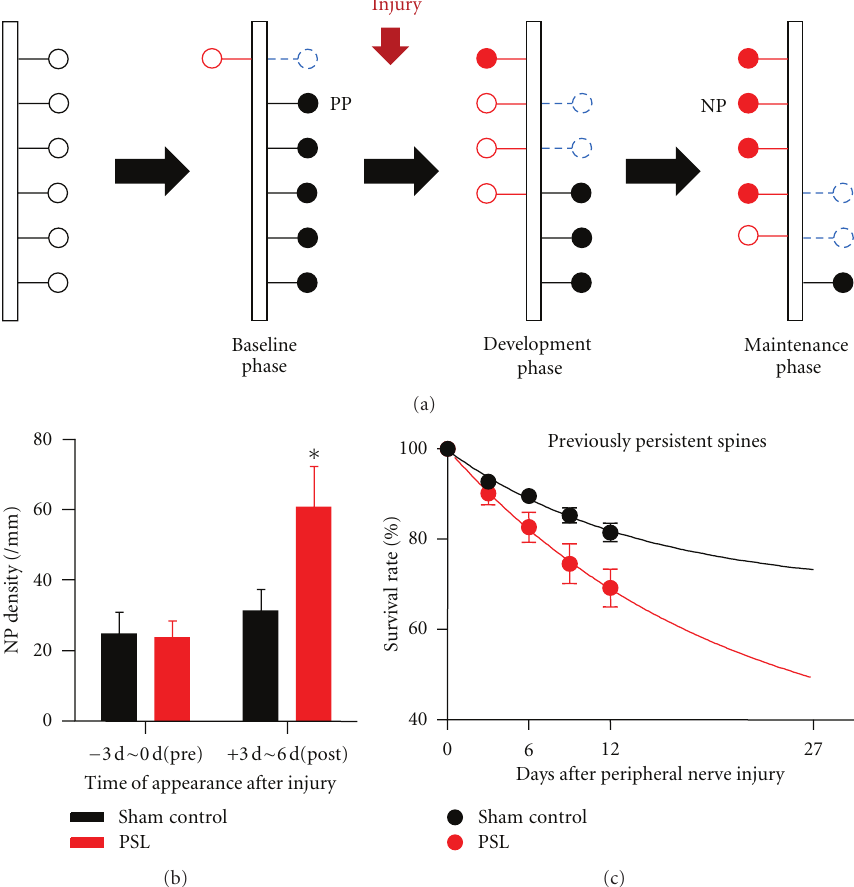
Figure 2: Neuropathic pain injury increases the formation of new persistent spines and increases elimination of previously persistent spines. (a) Simplified model for spine formation (red open circles) and elimination (blue, dashed open circles) under basal conditions and during neuropathic pain. PP: previously persistent spines (black filled circles). NP: new persistent spines (red filled circles). Note the increase in NP spines (b) and decrease in PP spines (c) following PSL injury. (b and c) Reproduced and adapted, with permission, from